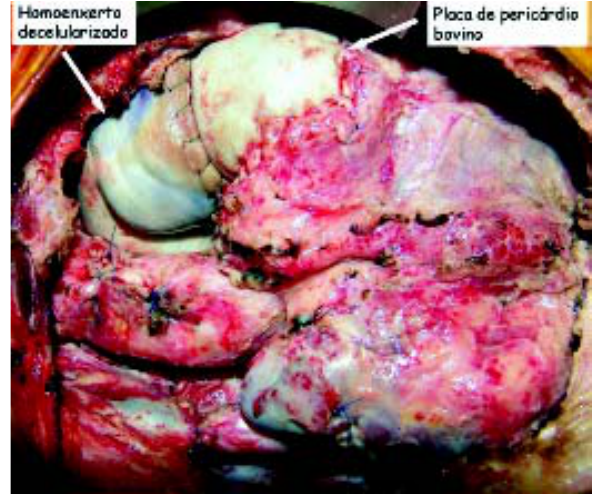
Fig. 4 – Aspecto final após implante do homoenxerto decelularizado completado com placa de pericárdio